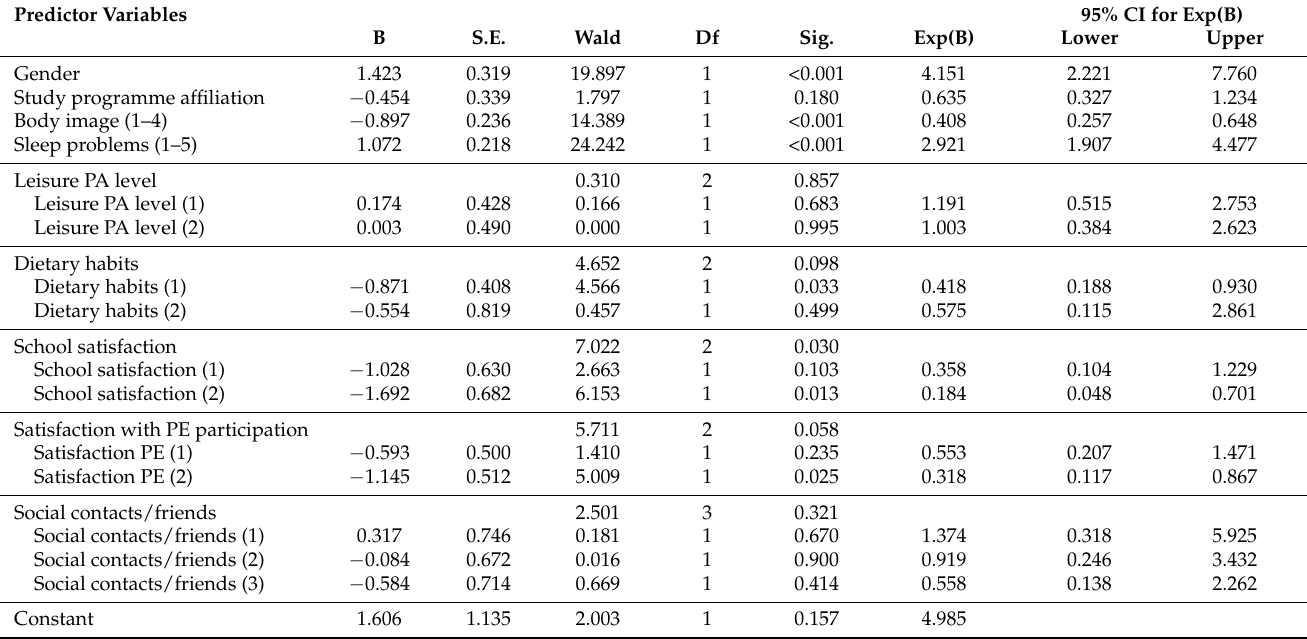
Table 2. Results from the binary logistic regression